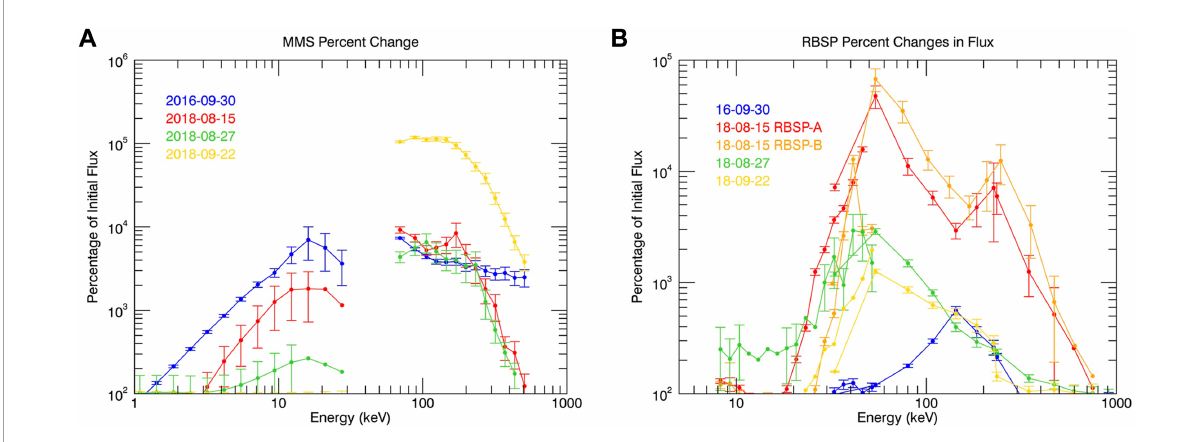
FIGURE 4 Percent change of electron flux from before the energization/injection to the peak of the energization/injection, (A) at MMS and (B) Van Allen Probes. The colors are consistent between the two, so blue (30 September 2016, 01:09 UT), green (27 August 2018, 07:49 UT), and yellow (22 September 2018, 20:10 UT) show the same events on each graph. The red event (15 August 2018, 11:59 UT) in MMS has observations from both Van Allen Probes, so both the red and orange line on the right correspond to